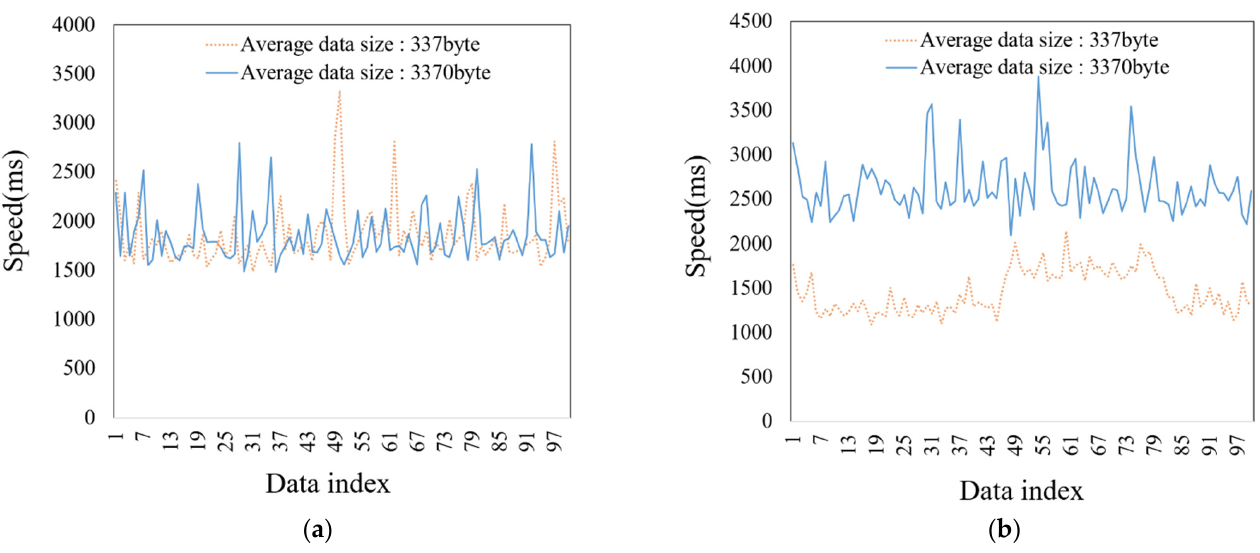
Figure 11. ( a ) Data upload speed through the system for each data size, ( b ) original data upload speed for each data size.